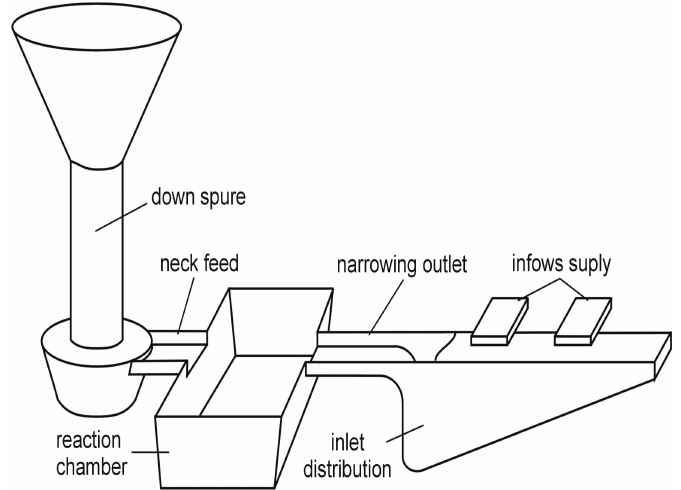
Figure 1. Scheme of the gating system for the in-mold